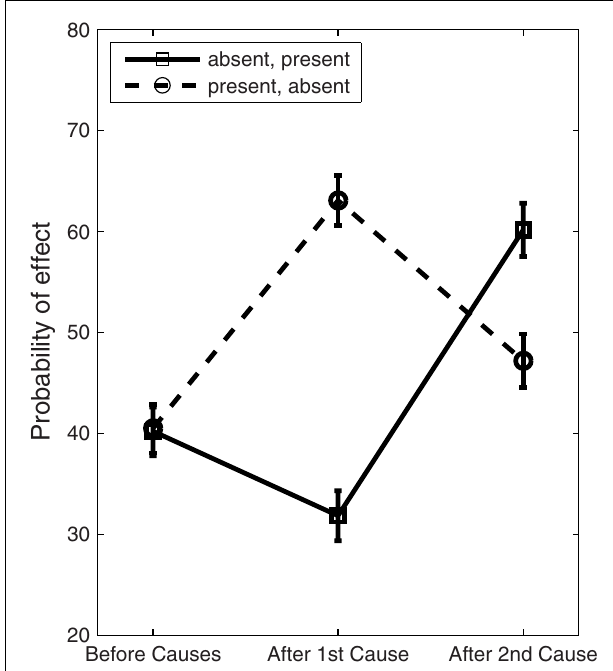
FIGURE 1 |Average probability judgments collapsed across 10 scenarios for two orderings of present and absent causes. The judgments exhibit a significant recency effect as illustrated by the crossing of the two curves on the graph. Error bars show the 95% confidence interval.